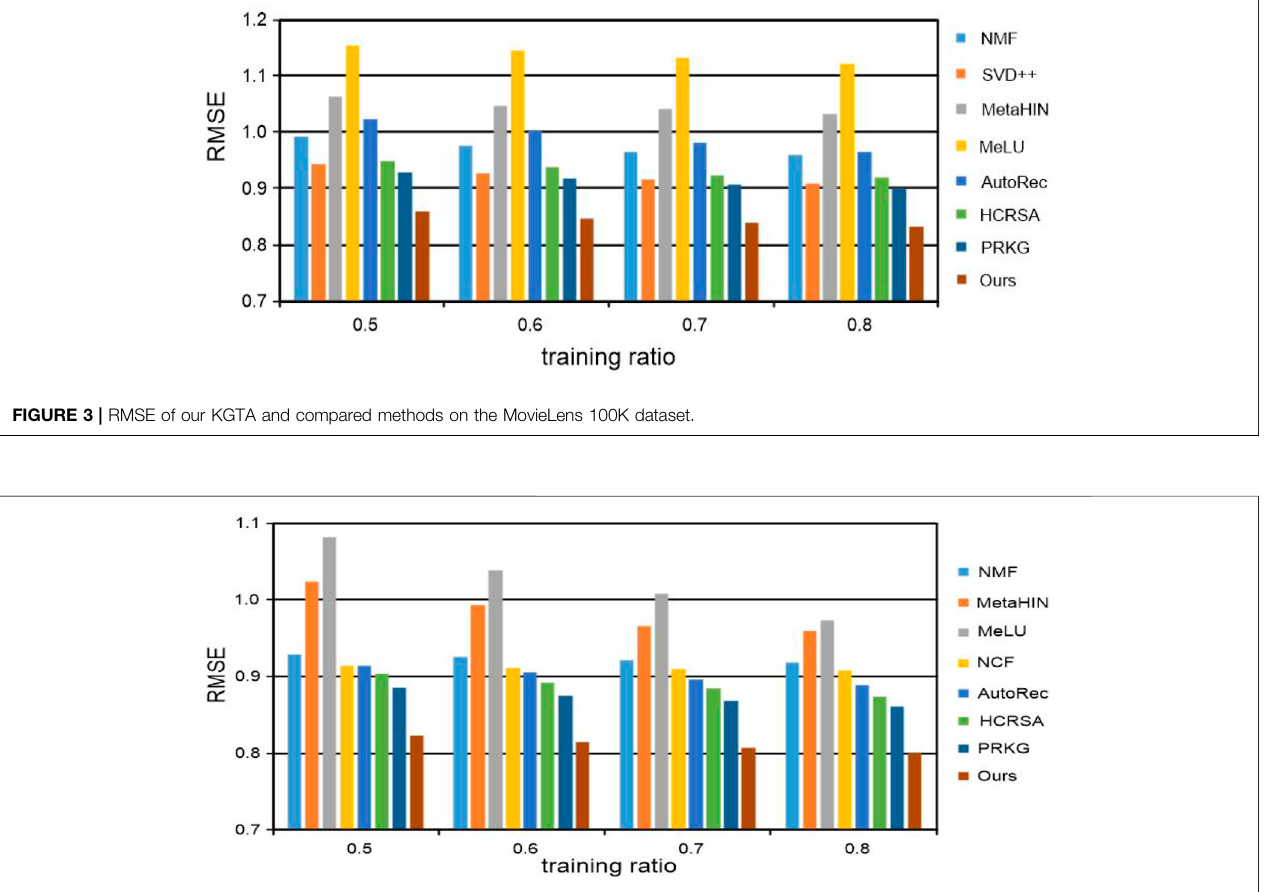
FIGURE 4 | RMSE of our KGTA and compared methods on the MovieLens 1M